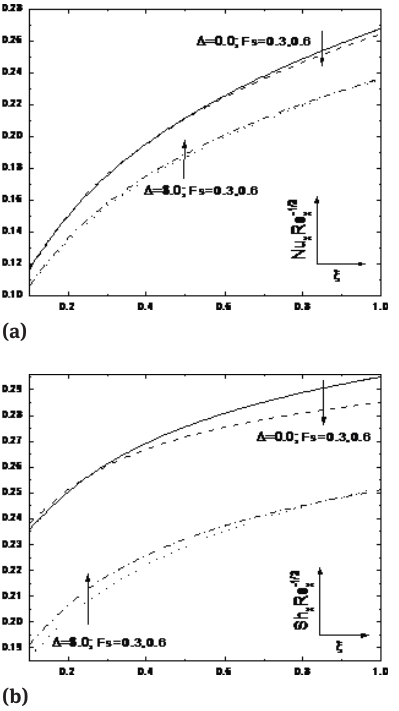
Fig. 7: The effect of Forchheimer and Coupling numbers on (a) local Nusselt number, (b) local Sherwood number for α 1 = 5, α 2 = 5, Ω = π /6, Bi =